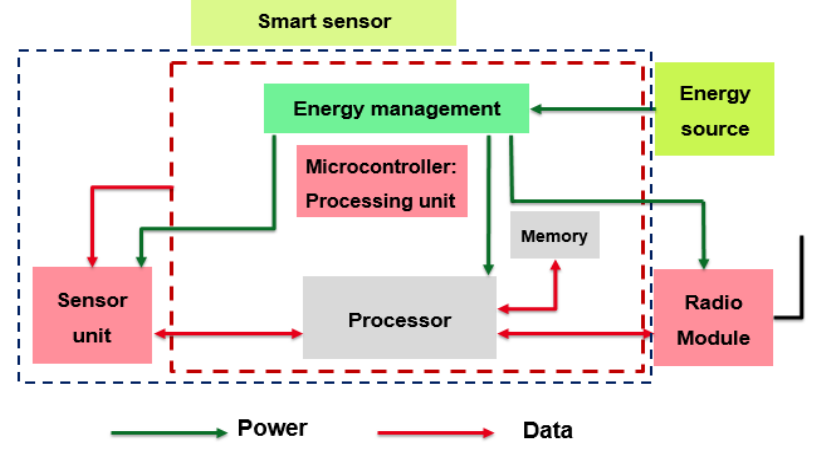
Figure 1. Sensor node